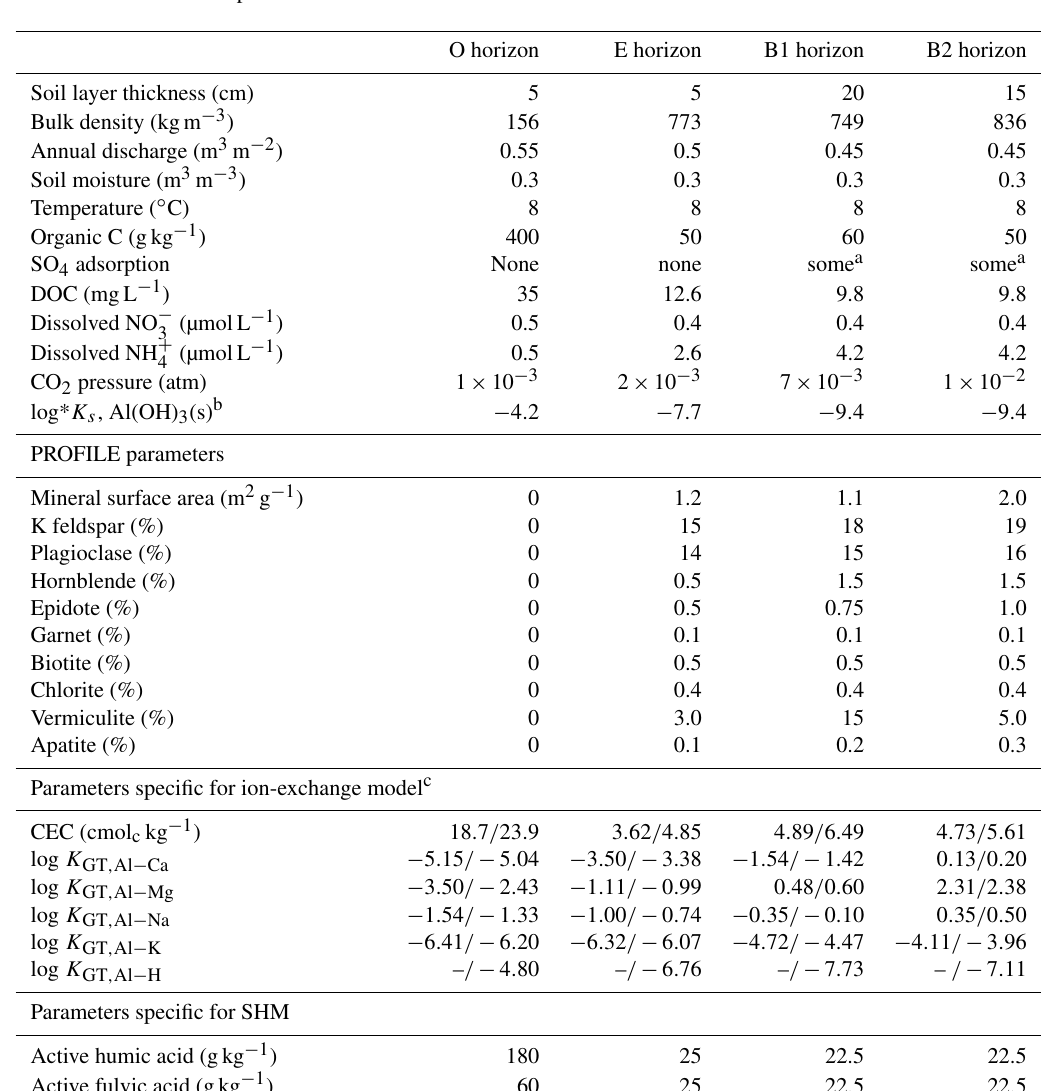
Table 1. Parameter values and assumptions.